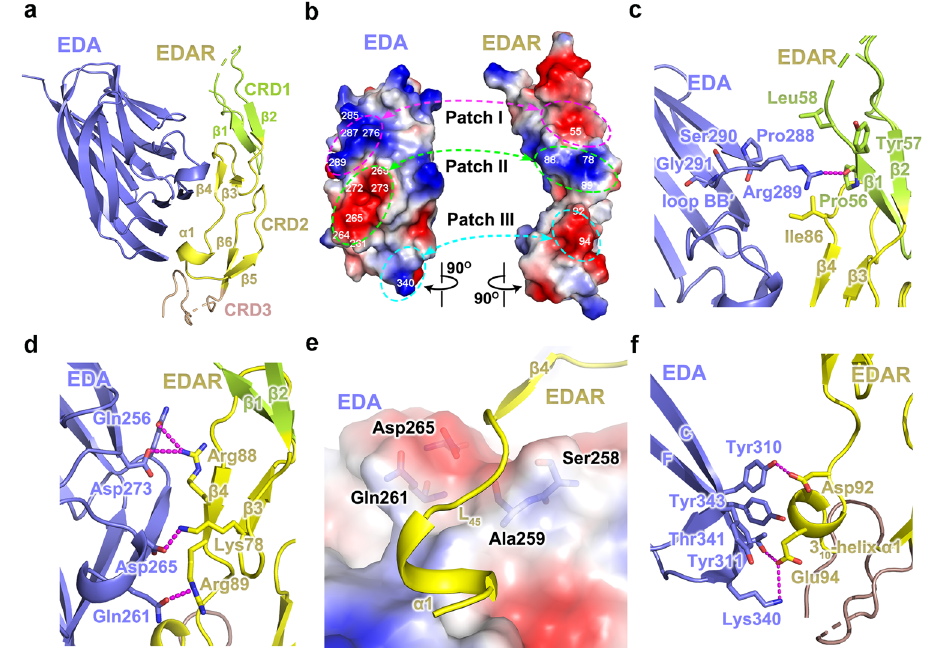
Fig. 2 | Interactions between EDA·A1 THD and EDAR CRDS . a The interaction betweenEDA·A1 THD andEDAR CRDS ismainlymediatedbyCRD2ofEDAR CRDS .CRD1, CRD2 and CRD3 are highlighted in limon green, yellow and wheat, respectively. b TheelectrostaticsurfacepotentialofthebindingsiteinEDA · A1 THD andEDAR CRDS . Threepairsofsurfacepatcheswithoppositeelectrostaticpropertiesimportantfor theligand-receptorinteractionarehighlightedindashedcircles.Positivepotential, blue; negative potential, red. c , d Detailed interactions at patches I and II between